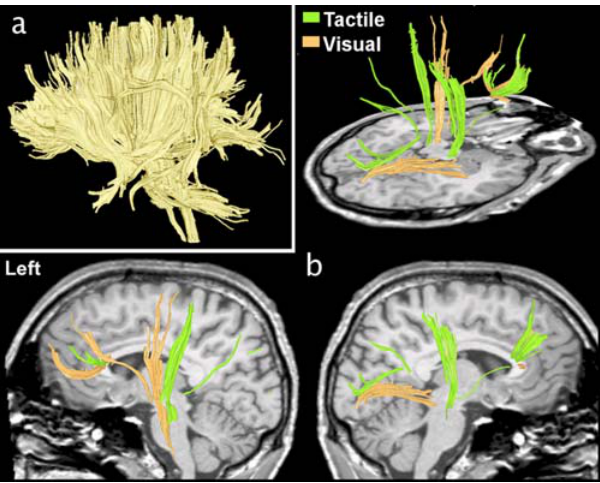
Figure 2. Individual fDTI results for subject 5. (a) The reconstructed tracts that were tested for activity using the fDTI method. (b) Tracts that were found positively active during the visual task (orange) and the tactile task (green). The lower images show the tracts found for the left and the right hemisphere. During the tactile task, positively correlated activation was found predominantly contra- laterally for thalamocortical tracts running to the primary sensory cortical area. Positively correlated activation during the visual task was found amongst others for tracts that are part of the optic radiation.